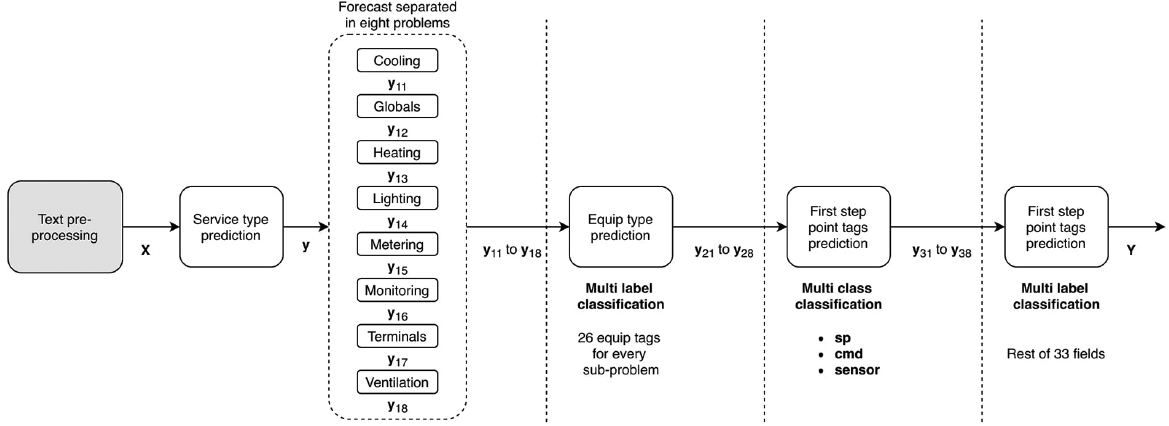
Figure 8. BMS label classification for the whole Table 10. Percentages of true/false positives/negatives with respect to the total length of the test set for all predictions, 1875 labels Service type